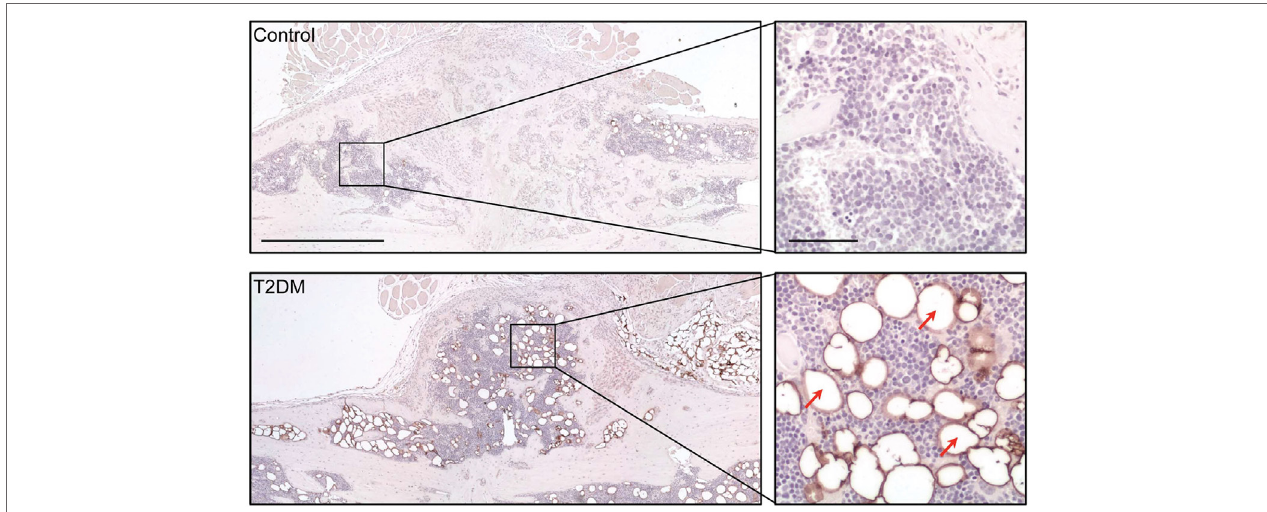
FigURe 3 | Assessment of adipocyte presence in the fracture callus of control and type 2 diabetes mellitus (T2DM) mice tibiae through immunological staining for peripilin. Right panels show a magnified area of the sections, where stained adipocytes (red arrows) can be appreciated more clearly. Timepoint post-fracture surgery: 21 days. Black scale bar in left panel = 1 mm. Black scale bar in right panel = 100 µm. Figure taken and adapted from Ref.